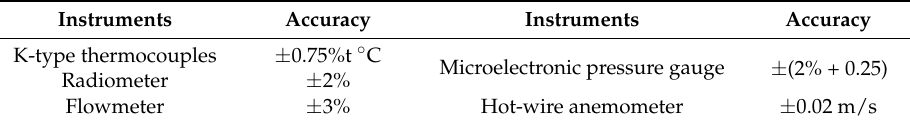
Table 1. Accuracy of the instruments used in the experiment.